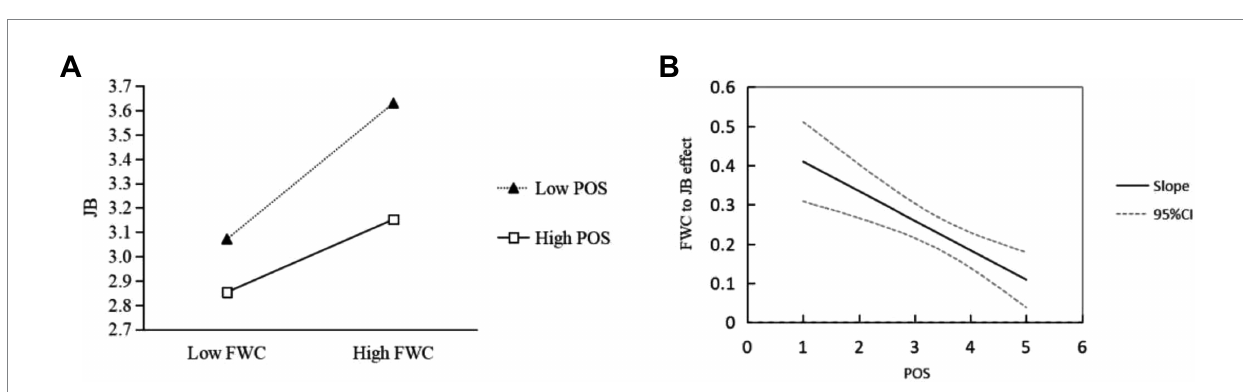
FIGURE 4 Moderating effect of POS on the relationship between FWC and JB A : Simple slope test of moderating effect B : Johnson-Neyman analysis of moderating